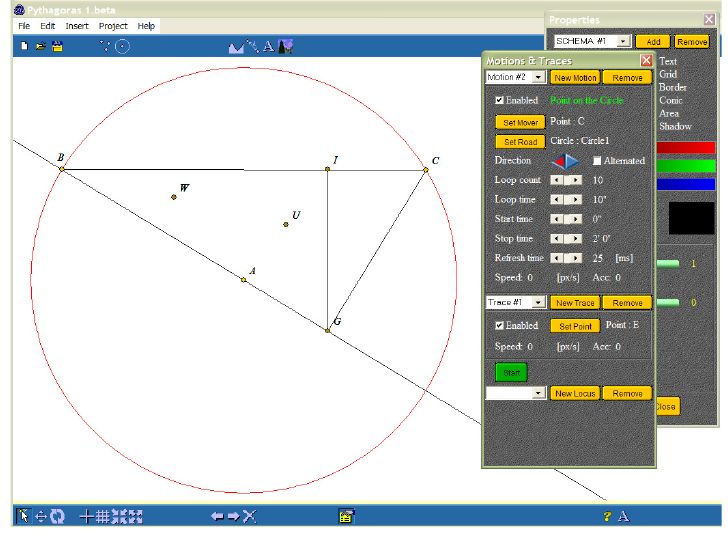
Figure 1. Example of a simple geometric